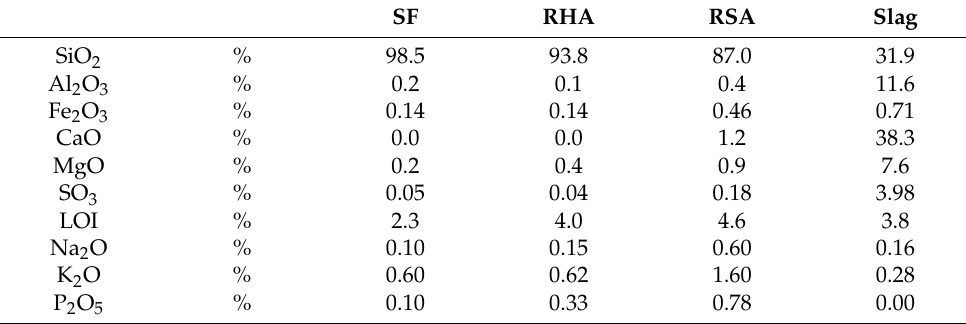
Table 1. Chemical composition of the materials